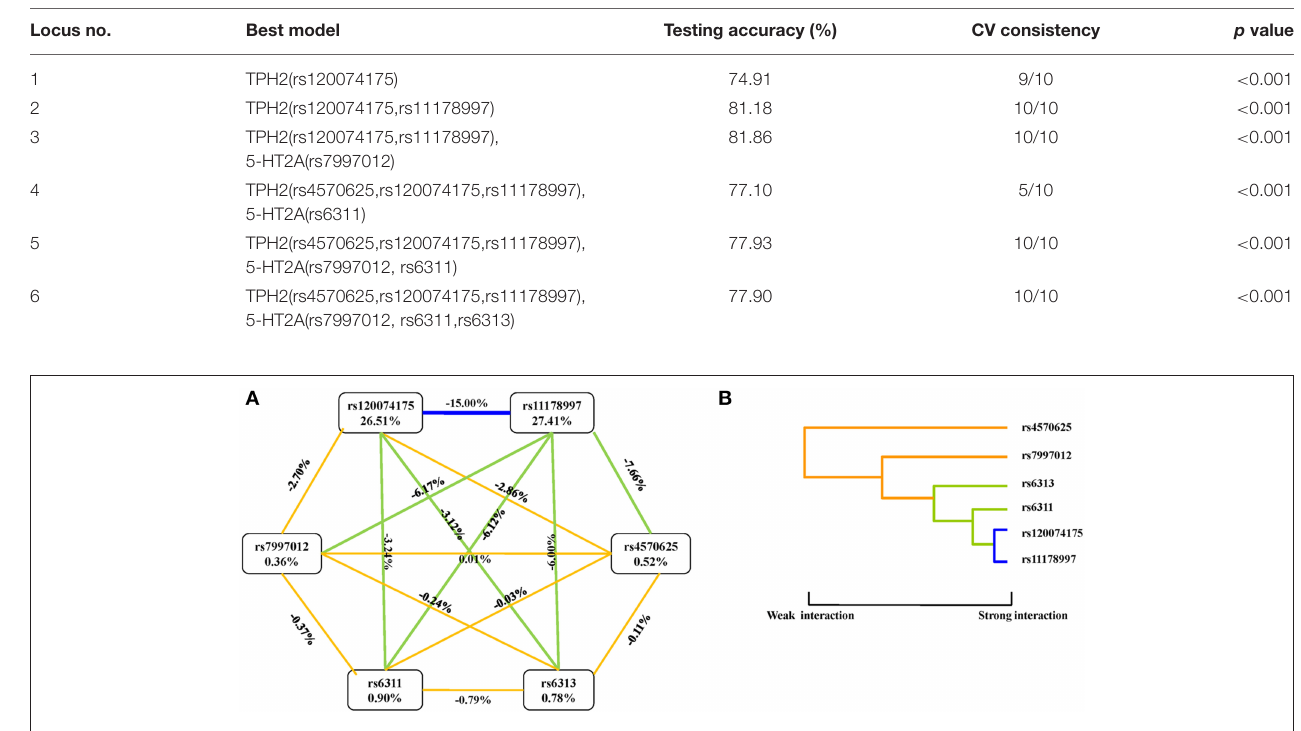
reported an association of rs120074175 with unipolar major depression